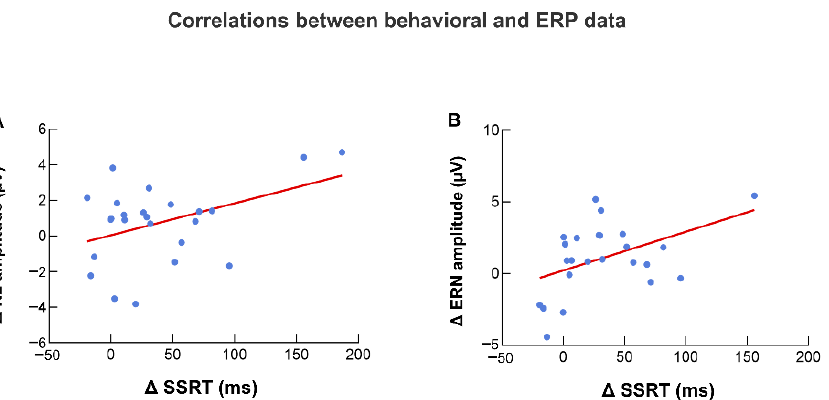
Figure 7. Grand mean ERP waveforms of table tennis athletes and controls on P3 in baseline state (BS) and 36 h sleep deprivation (SD) conditions. The data were averaged from F3, F4, Fz, FCz, and Cz. The topographies correspond to average activity in the time windows (250–400 ms, indicated by the gray bar) around the local peaks.